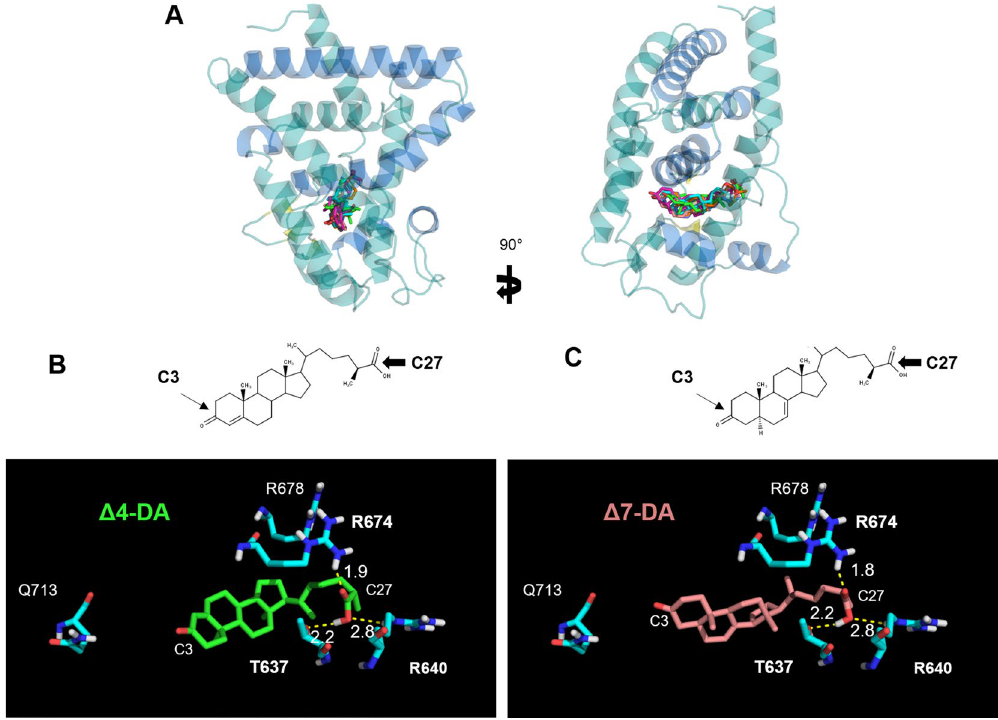
Figure 4. Binding mode of dafachronic acids on model of DimDAF-12 ligand binding domain. A In silico docking of dafachronic acids (DAs) into the model of DimDAF-12 LBD was performed using Autodock. Δ4-DA and Δ7-DA bind inside the ligand binding pocket of DimDAF-12. The structures of Δ4-DA ( B ) and Δ7-DA ( C ) differ in the position of an unsaturated double bond respectively at C4 or C7 of the steroid nucleus. H-bonds are illustrated by yellow dashed lines with bond lengths noted in Å. All images were generated using PyMol 1.3 (https ://pymol